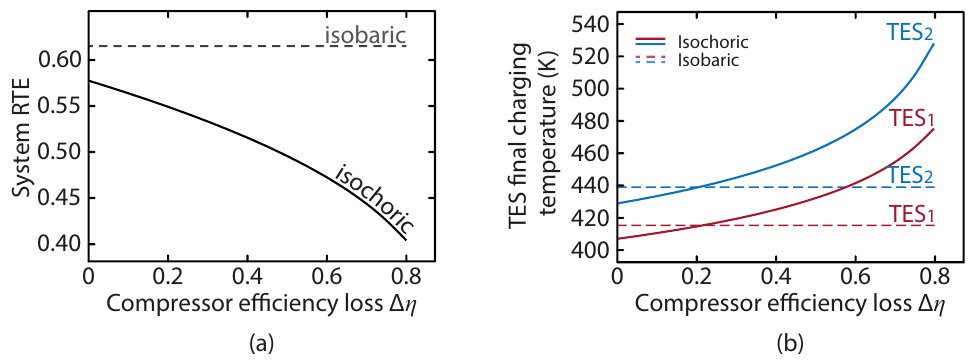
Figure 8. Composite plot comparing key differences between the isobaric and isochoric system performance figures as a function of the compressor efficiency loss ∆ η = η ( χ REL = 1 ) − η ( χ REL = 0 ) . In ( a ) Isochoric system Round-Trip Efficiency (RTE) compared to the isobaric system RTE (constant); and ( b ) TES 1 and 2 final charging temperatures in isobaric and several isochoric